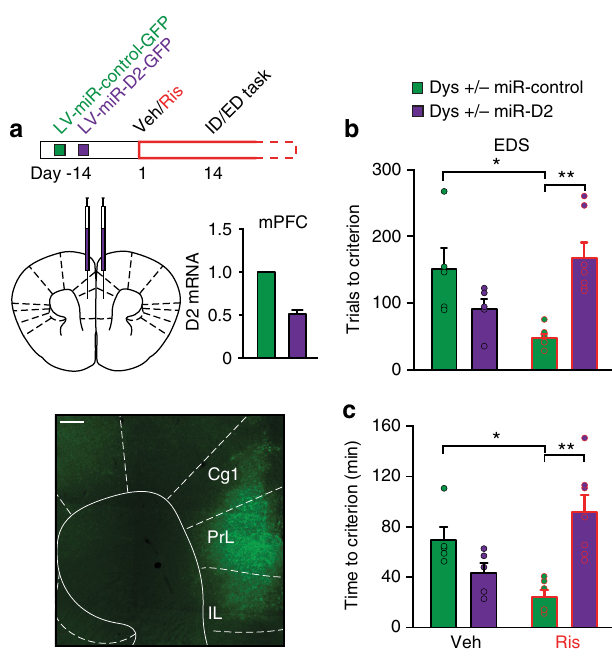
Fig. 4 Risperidone-dysbindin-1 interaction converges on D2 receptors in the mPFC. a Top, Dys + / − mice have been bilaterally injected in the mPFC with a lentivirus delivering a synthetic microRNA (miR) to inactivate speci fi cally D2 receptors (LV-miR-D2) or a control miR (LV-miR-control), coupled to a GFP tag. After 2 weeks, animals received daily injections of Veh or Ris for 14 days before the beginning of the ID/ED task and then throughout the experiment. Bottom, Injection, expression of LV-miR-D2-GFP and D2 receptors mRNA relative expression in the mPFC of Dys + / − mice. Scale bar 200 μ m. Cg1, cingulate cortex; PrL, prelimbic; IL, infralimbic. b , c Dys + / − risperidone-treated mice after D2 silencing (Dys + / − miR-D2/Ris, green bar, Ris in red) needed ( b ) more trials (one-way ANOVA, F (2, 15) = 13,21, p < 0.0005, n = 5 – 7 each group) and ( c ) more time ( F (2, 15) = 11,84, p < 0.005) to complete the EDS of the ID/ED task than risperidone-treated Dys + / − that received a control miR (Dys + / − miR-control/Ris, purple